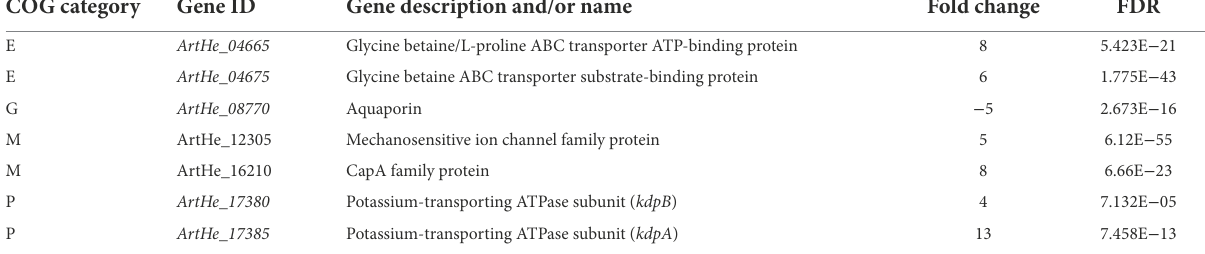
TABLE 1 DEGs related to osmotic stress in PEG35 vs.